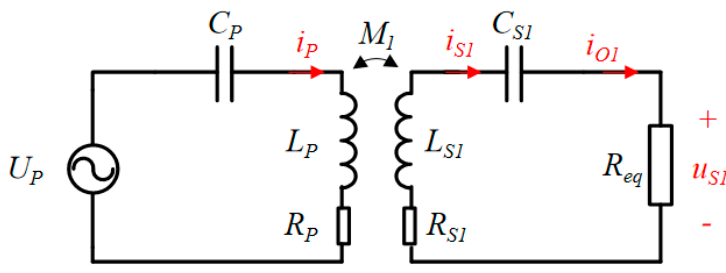
Figure 12. Equivalent S-S compensation topology.